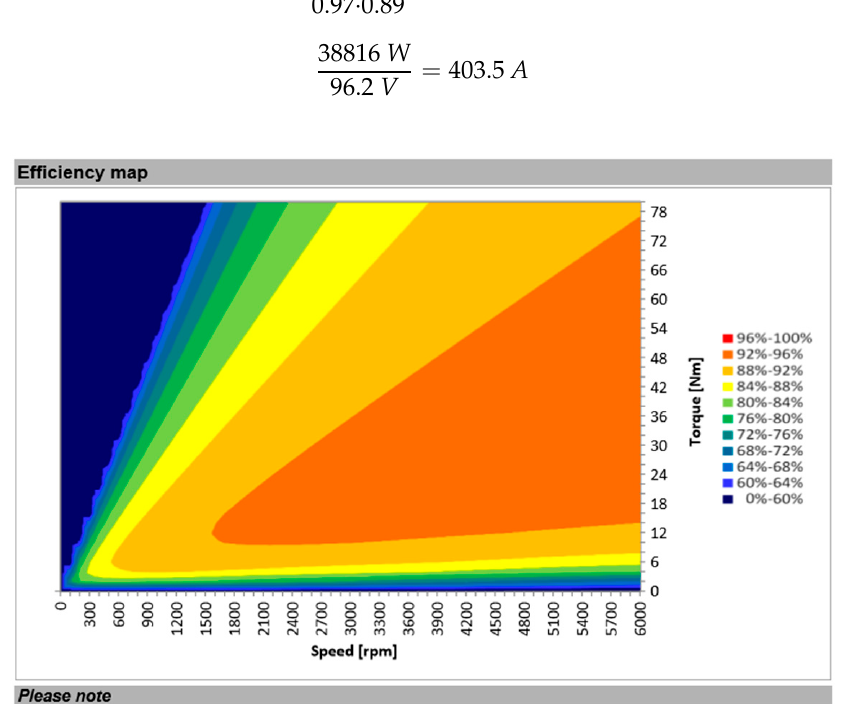
Figure 5. Efficiency curve of the Heinzmann PMS150 motor [22]. Figure 5. E ffi ciency curve of the Heinzmann PMS150 motor